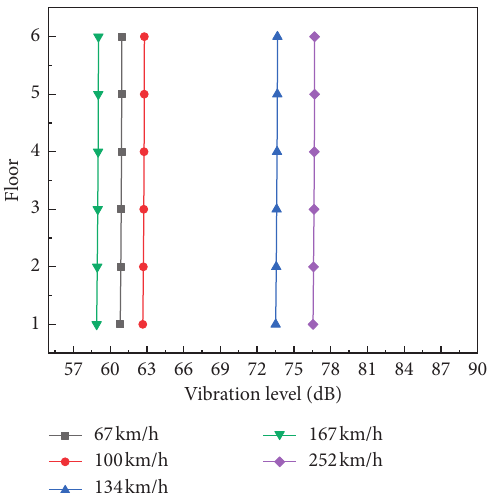
Figure 6: Building vibration of different floors under different vehicle